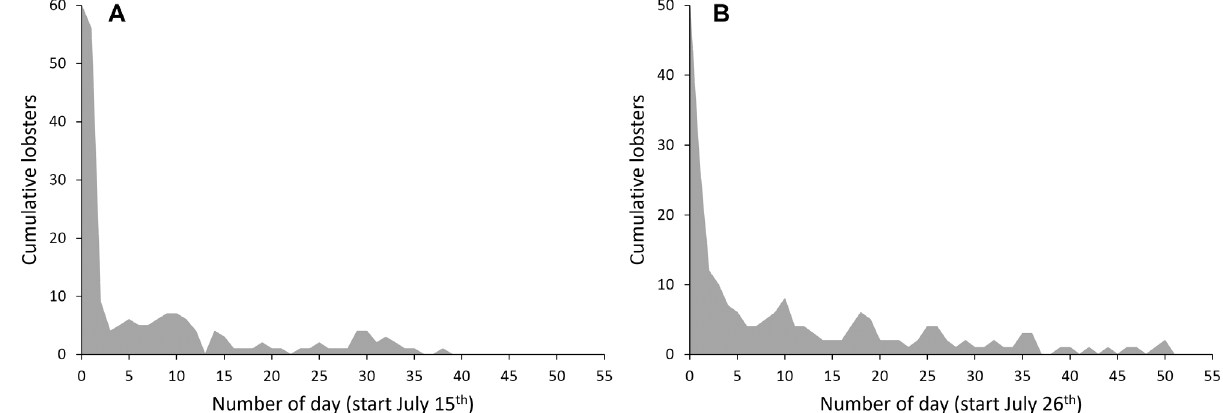
Fig. 4. Cumulative number of lobsters detected by the acoustic arrays during the 55 d following the start of the experiment in (A) 2014 and (B)